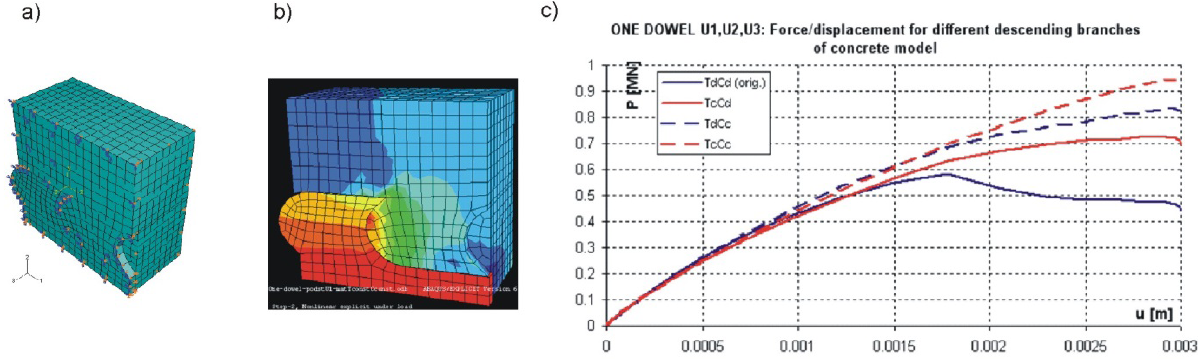
Figure 15: The 1D1 model is one of the first models prepared for the purposes of the PreCo-Beam project [7]. The displacement layout of the model with a maximum value (red) of 3 mm results in force displacement for particular material curves according to Fig.